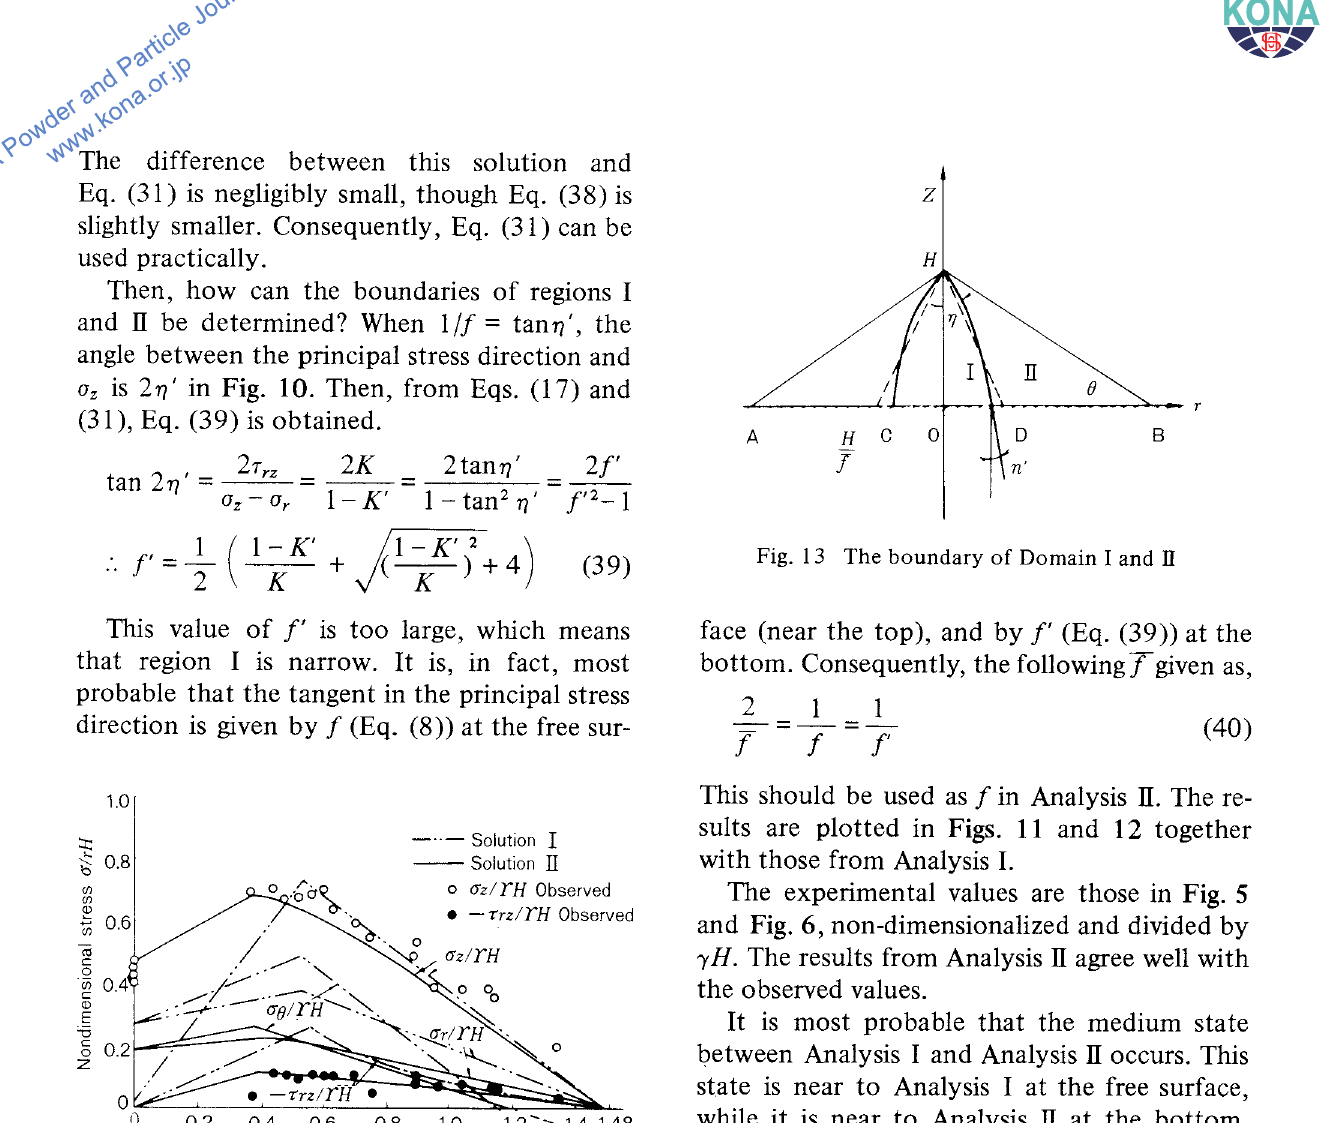
Fig. II Bottom stress distribution for Silica Sand